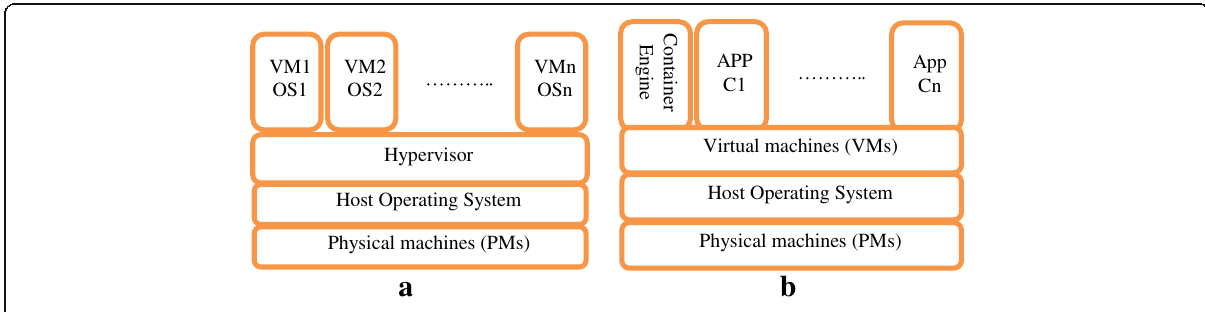
Fig. 1 Virtualization technology. a . Virtual machine architecture. b . Container virtualization